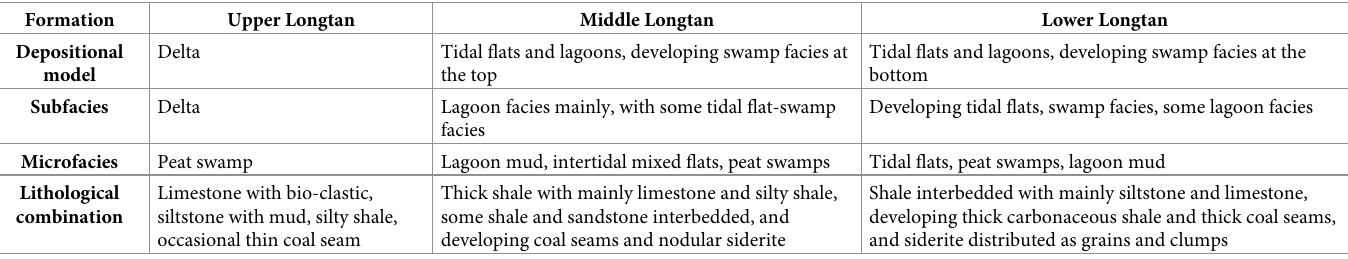
Table 1. Comparison of lithological combinations in the Permian Longtan Formation, Well X1, southeastern Sichuan Basin.